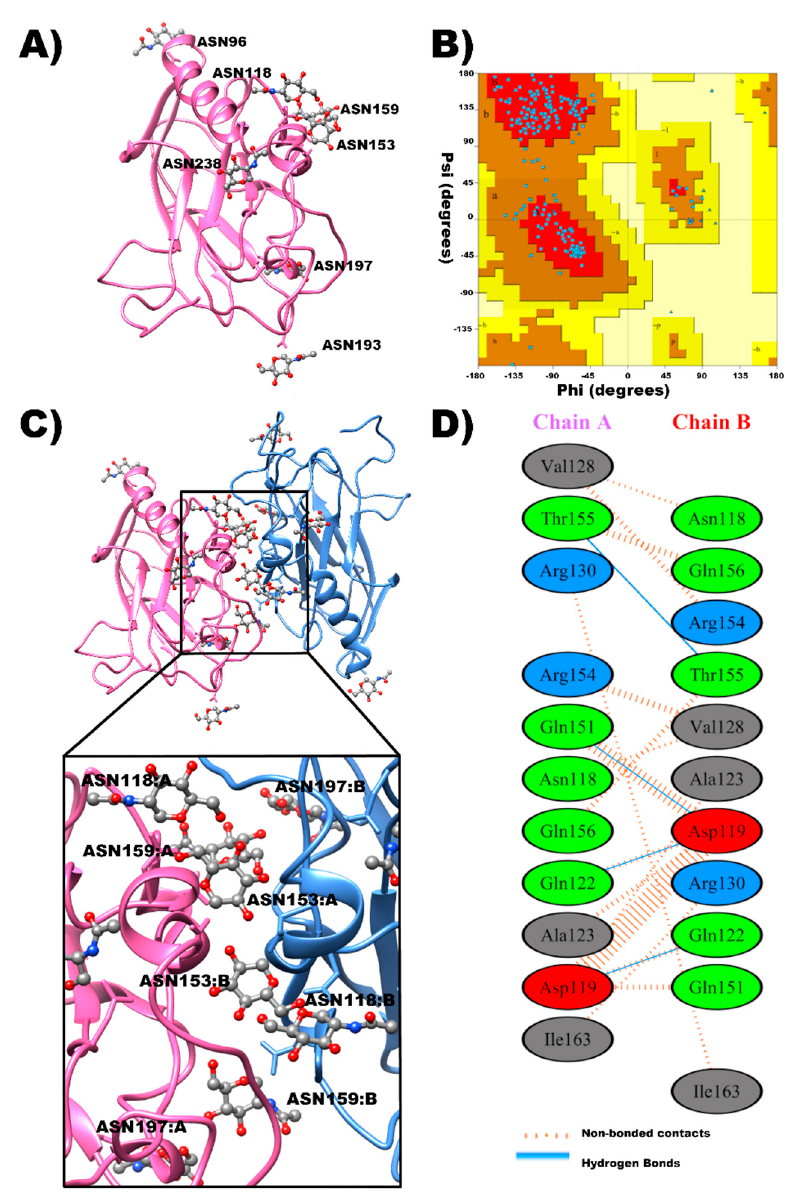
Figure 1. Monomeric and dimeric 3D structures of ED β 2 . ( A ) 3D structure of the ED β 2 monomer including its 7 N-glycosylation sites. ( B ) Ramachandran plot of the ED β 2 monomer. ( C ) Dimeric structure of ED β 2 , in which Chain A is colored in pink, Chain B is colored in blue, and N- glycosylation sites are marked in ball and sticks. An expanded view of the putative trans binding interface between adjacent ED β 2 is illustrated to visualize the four N-glycosylation sites. ( D ) Residue–residue interactions in the interface of the dimeric structure of ED β 2 .